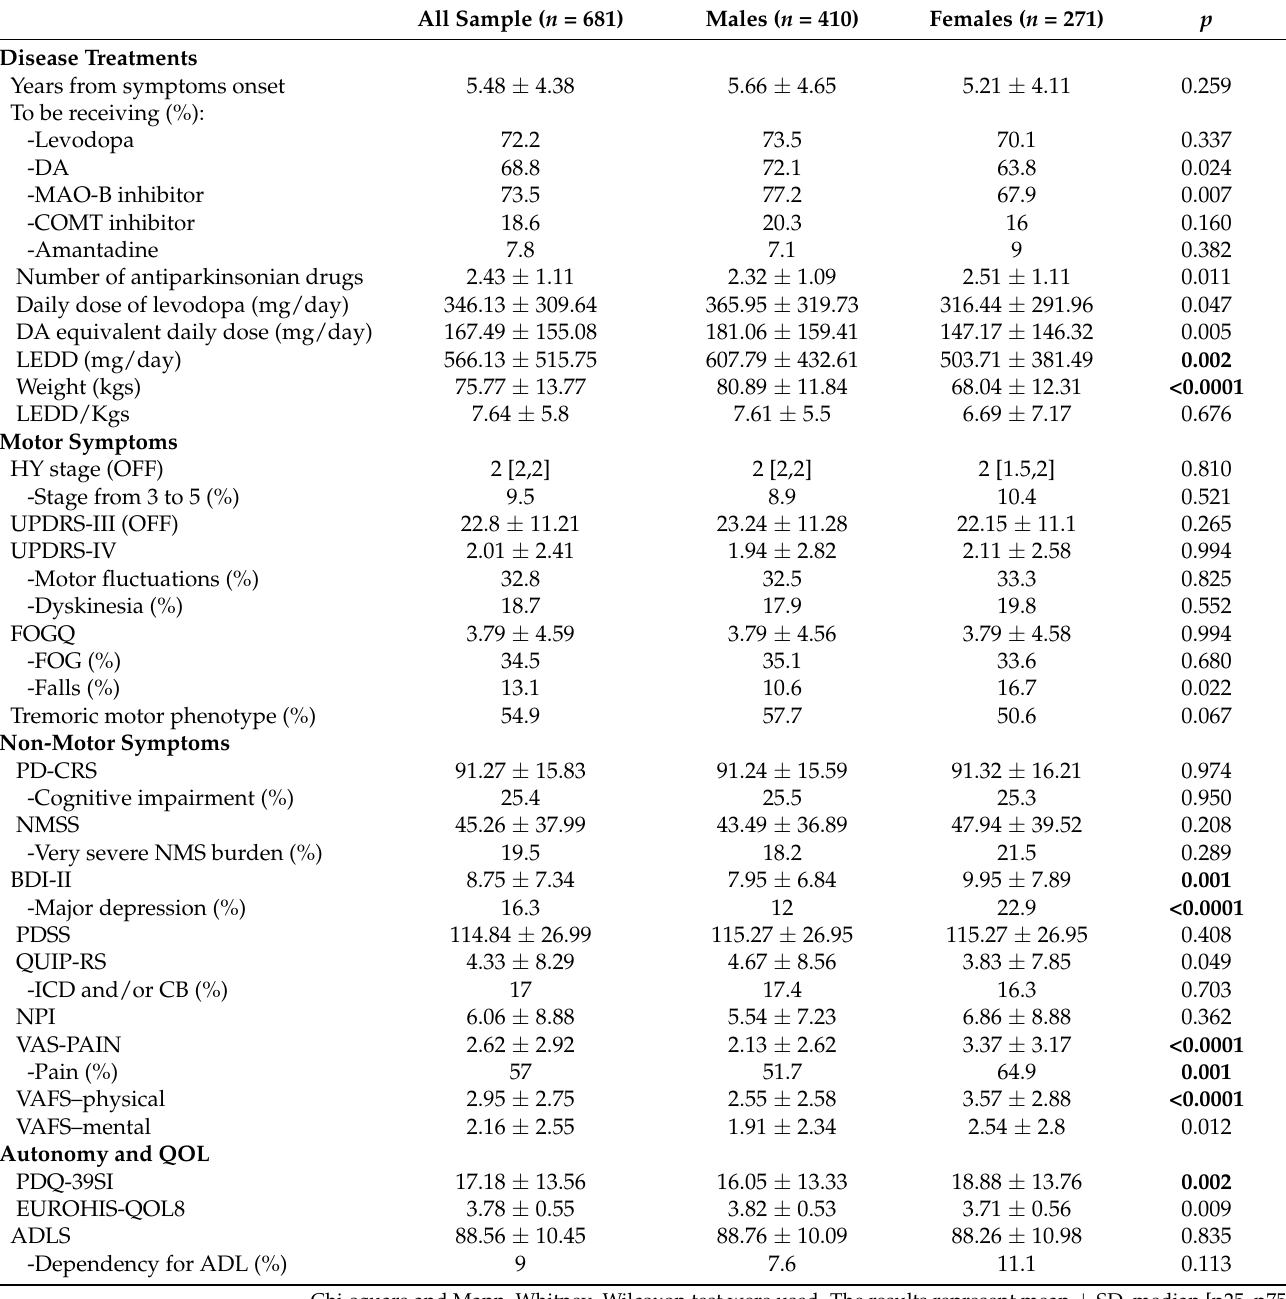
Table 2. Different PD-related variables in PD patients from the COPPADIS cohort at baseline (V0) regarding sex ( n =